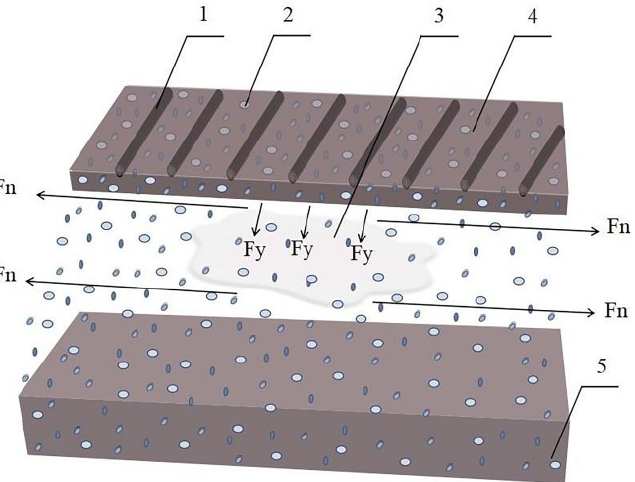
Figure 3. Stress diagram of residual film in soil. 1, Drip irrigation belt 2, Upper soil 3, Residual membrane debris 4, Soil 5, Lower soil.